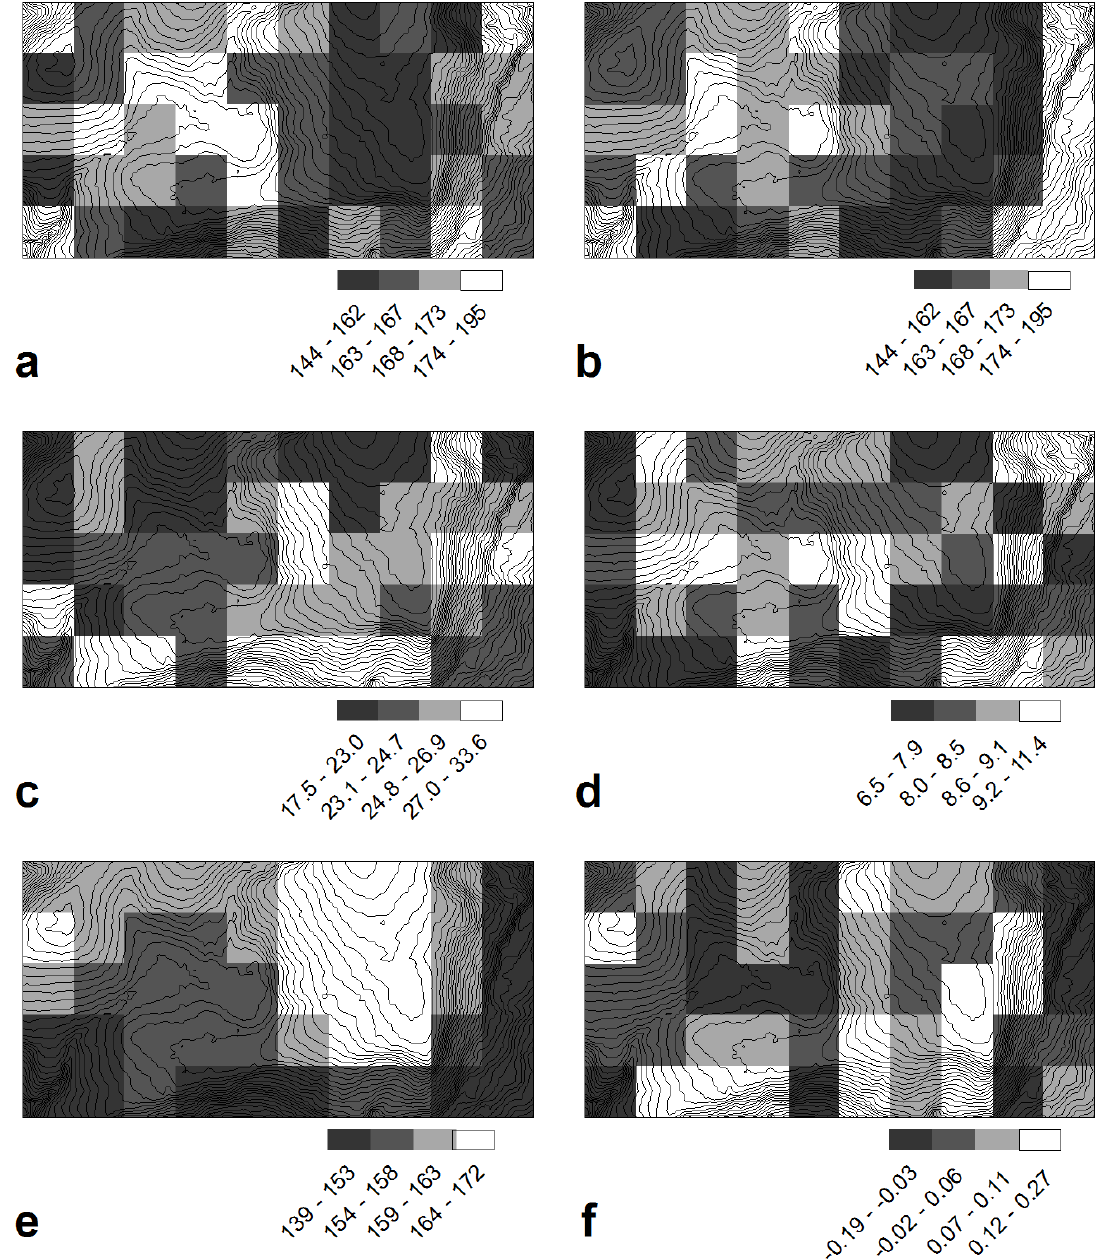
Figure 2. Maps of ( a ) observed species richness, ( b ) predicted species richness from 1.0-ha minimum Akaike’s Information Criterion (AIC) model, ( c ) mean canopy height (m); ( d ) standard deviation of maximum canopy height (m); ( e ) mean elevation (m); and ( f ) mean curvature (m − 1 ). Figures are shaded by quartiles, except predicted species richness, which is shaded by quartiles of the observed species richness